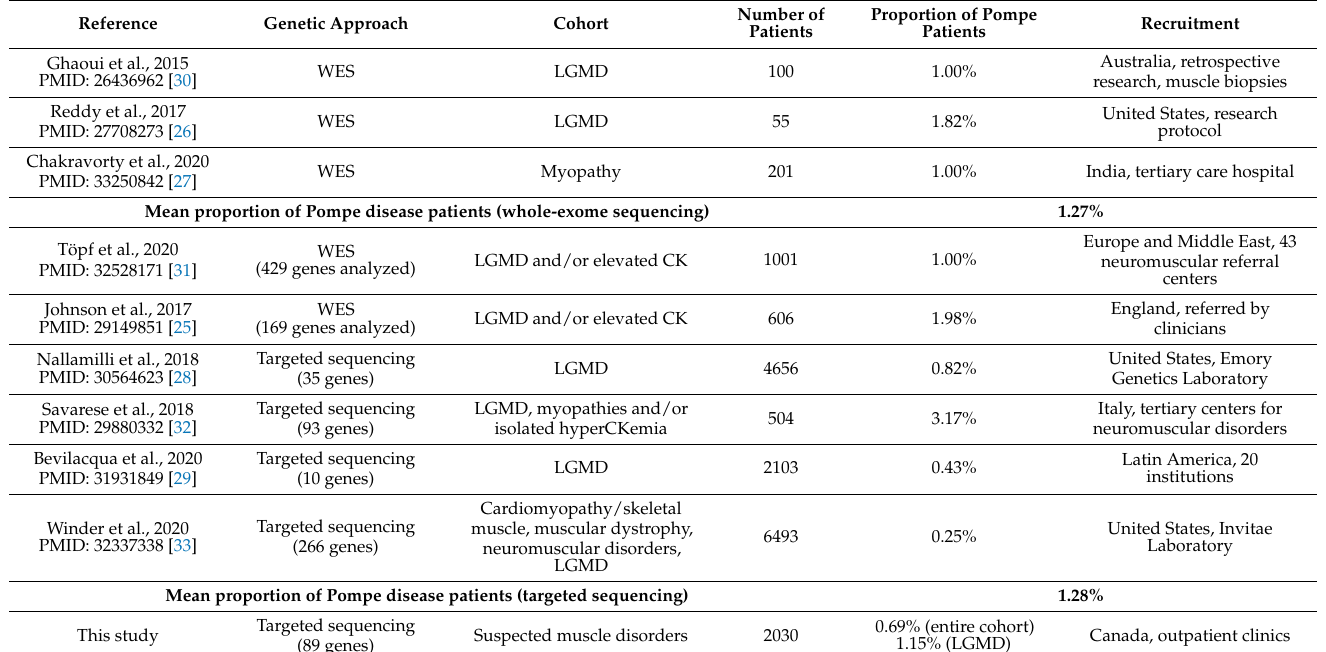
Table 2. Literature review of cohorts including patients with Pompe